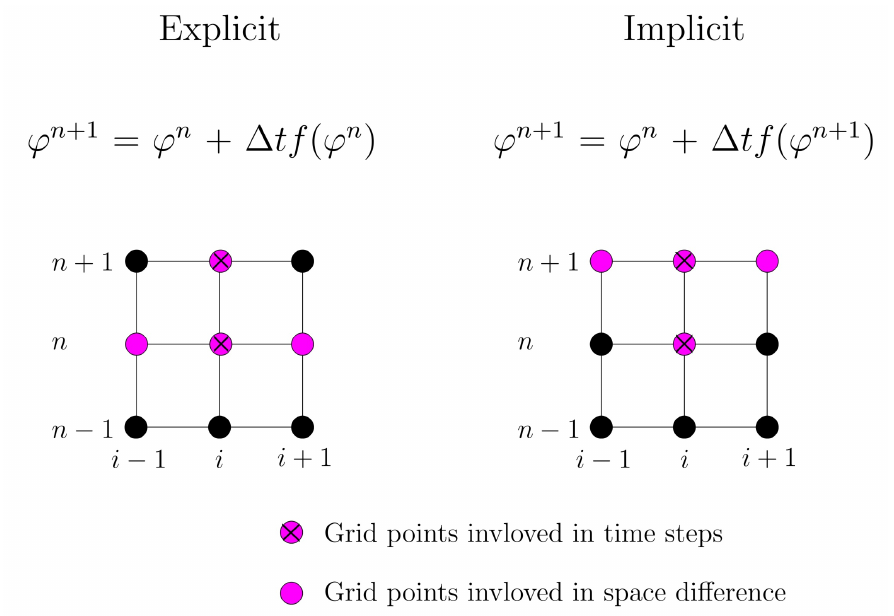
Figure 2. Unsteady flow solution: temporal discretisation methods and time-stepping